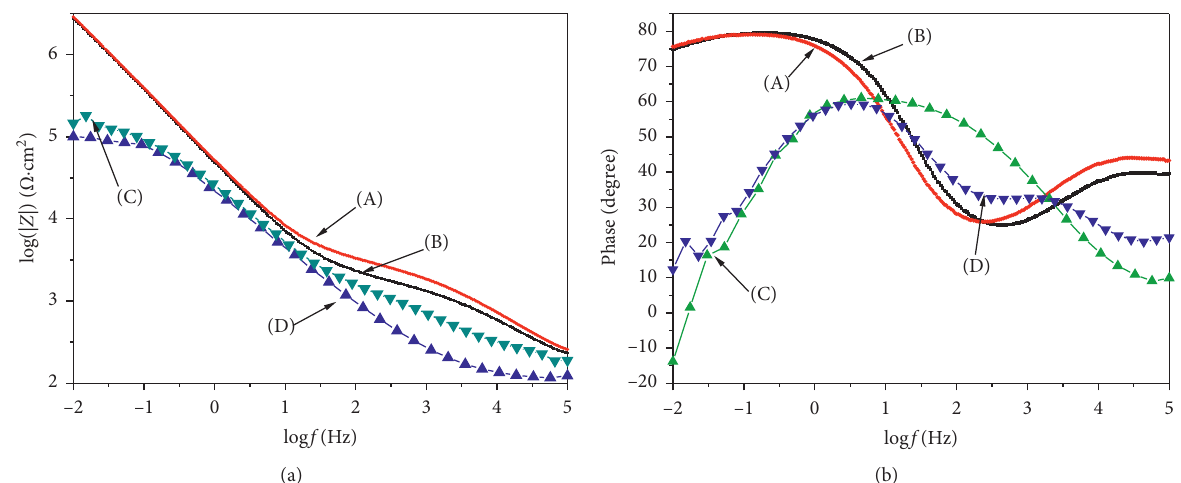
Figure 6: Impedance modulus. (a) Phase plots (b) after 1h immersion in 0.1M NaCl solution: (A) CeLDH, (B) CeLDH-H, (C) LDH, and (D) LDH-H.